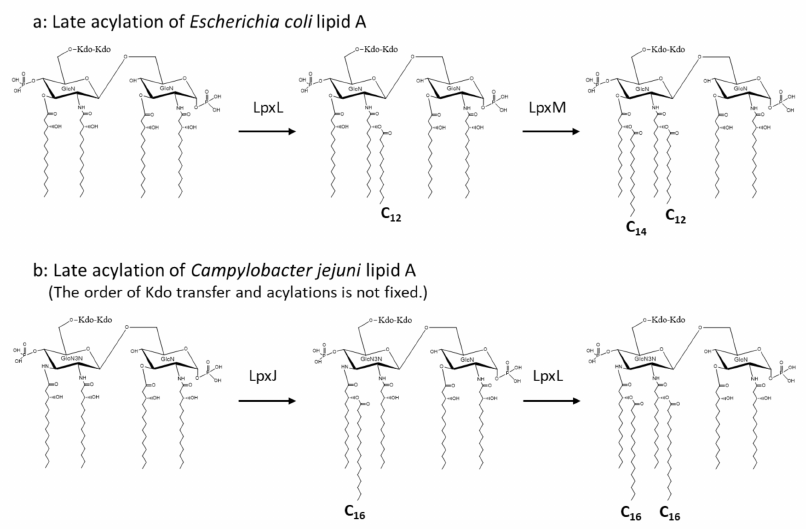
Figure 4. Acylation to form acyloxyacyl structure at the late stage of lipid A biosynthesis of Escherichia coli ( a ) and Campylobacter jejuni ( b